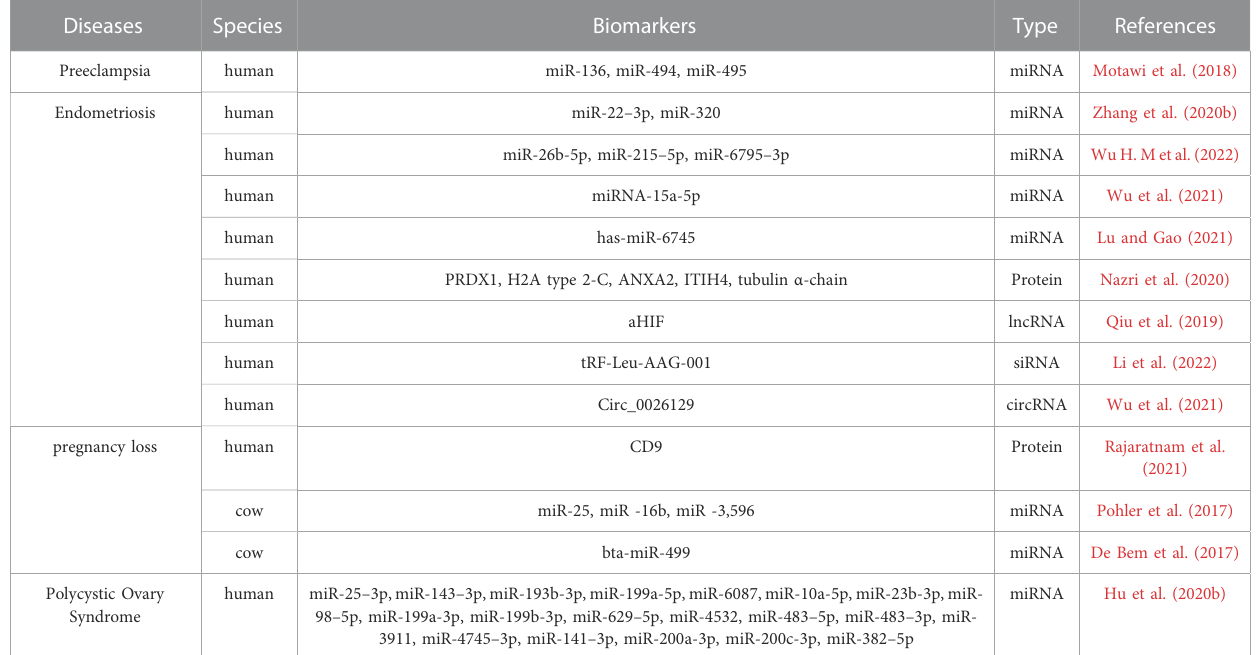
TABLE 1 Differential exosomes as biomarkers of pregnancy-related disease.